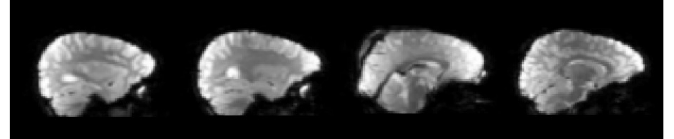
Figure 9. The sagittal plane of fMRI in children’s